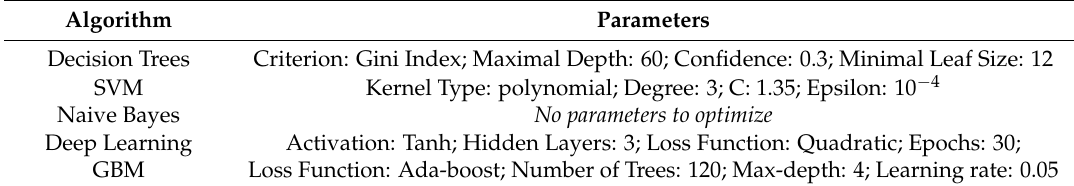
Table 3. Parameter values, upon the completion of the parameter tuning process for Experiment A.